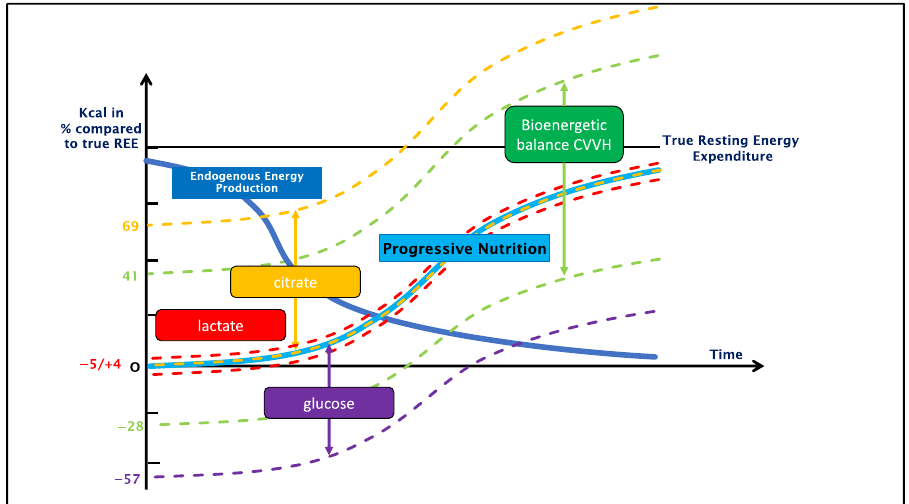
Figure 1. Bioenergetic balance of the CVVH compared to the true REE in relation to the ideal caloric delivery over time during progressive nutrition. This figure depicts the exchange of citrate, lactate and glucose in percentages compared to the true REE. It is placed against the need for progressive nutrition therapy, as recommended by the ESPEN guidelines [16], in relation to the endogenous energy production due to catabolism. The graph follows the recommendation of progressive nutrition therapy, illustrating the impact on total caloric load if the exchange of the different nutrients was not taken into consideration.